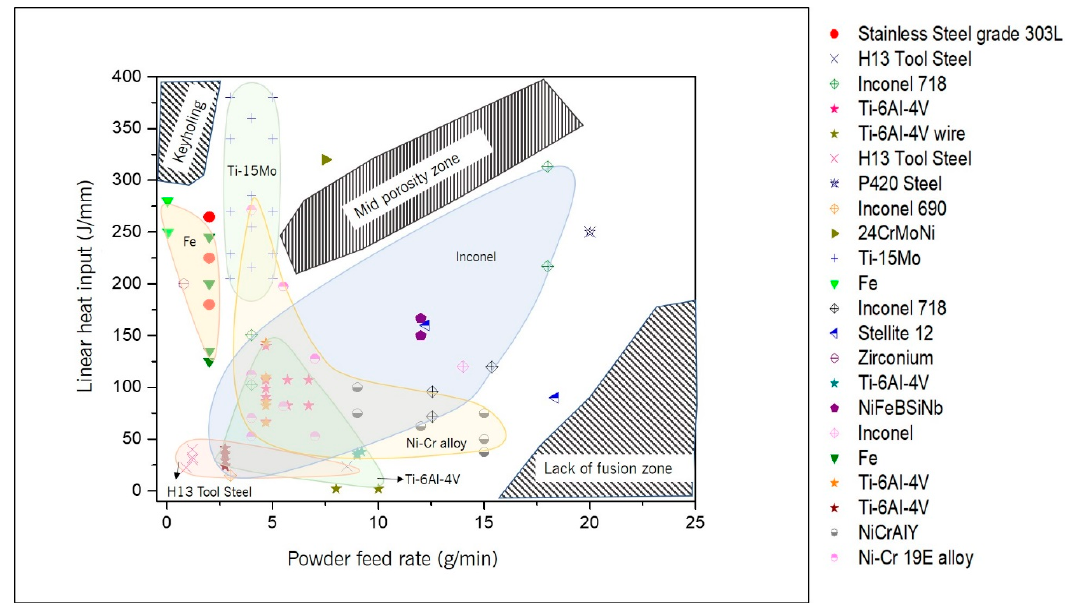
Figure 7. Optimal processing regions for Ti-6Al-4V, Inconel 690-718, Ni-Cr based alloys, Fe, H13 tool steel, and Ti-15Mo alloy, along with the unsuitable processing zones, as compiled in Table 5.